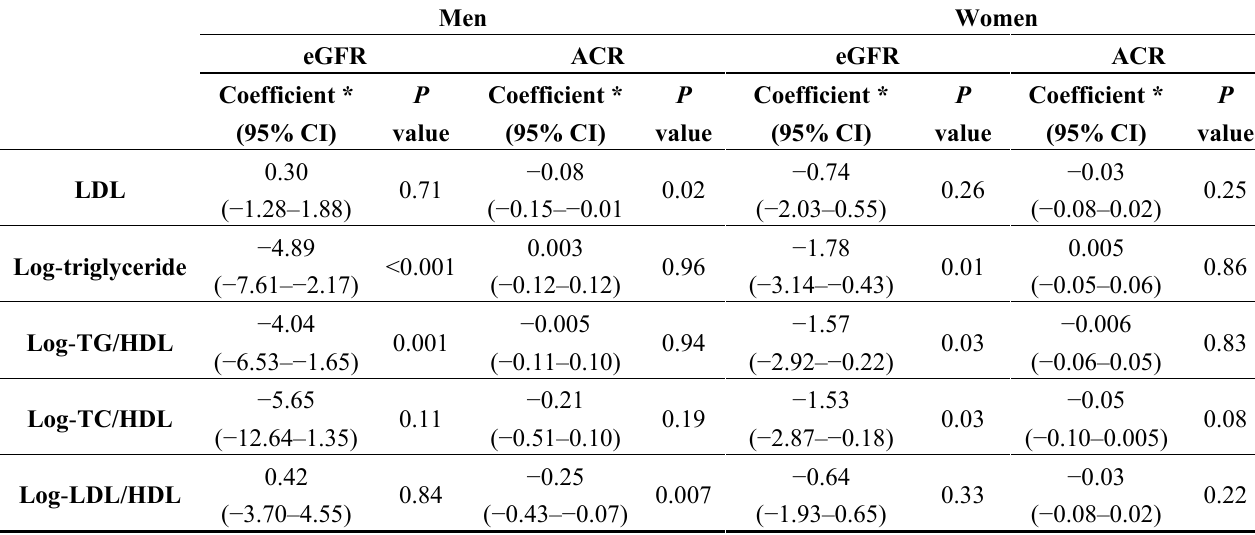
Coef. -2.76(-5.38, -0.14); P = 0.04 R-squared =